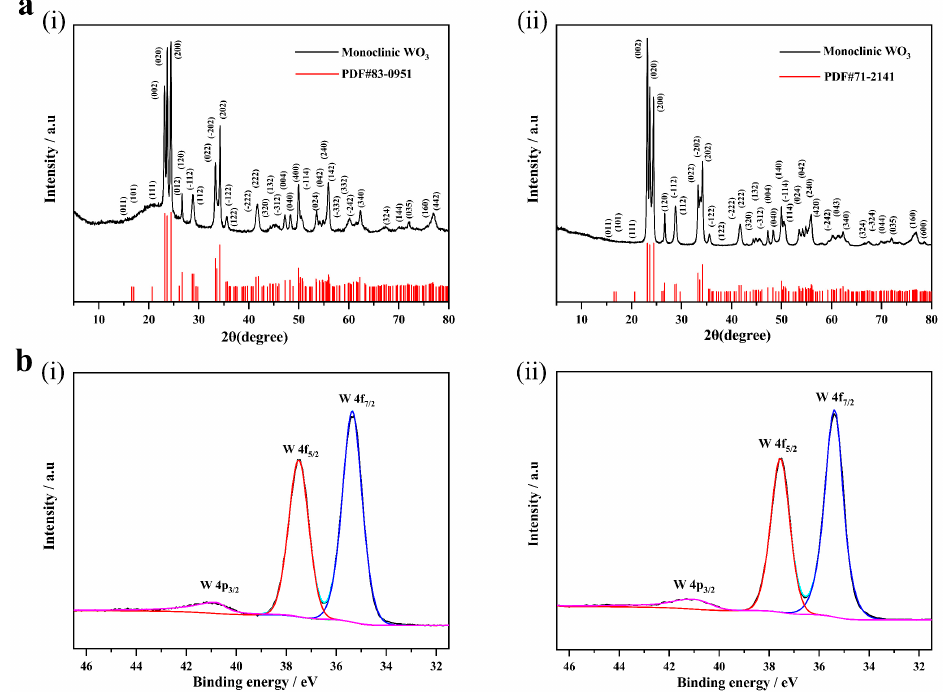
Figure 3. XRD and XPS spectra of the WO 3 powder. ( ai ) XRD spectrum of nanostructured WO 3 powder after annealing, ( aii ) XRD spectrum of ordinary WO 3 powder, ( bi ) XPS spectrum of nanostructured WO 3 powder after annealing, ( bii ) XPS spectrum of ordinary WO 3 powder.